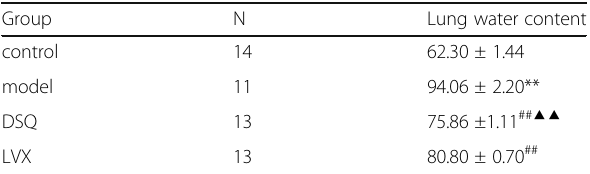
Table 1 Lung Water Content in each group (mean ±